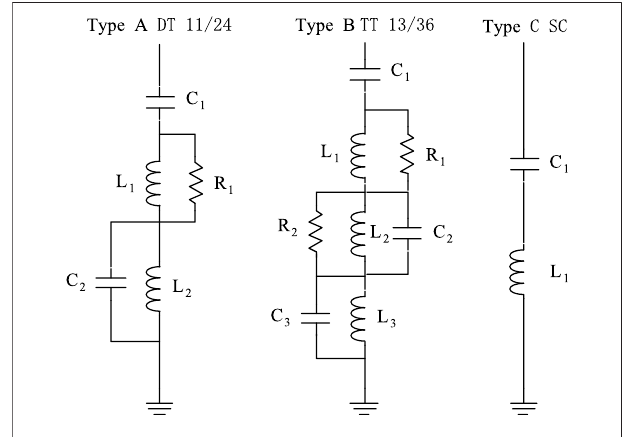
FIGURE 2 | Grouping wiring diagram of the AC fi